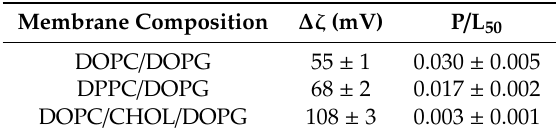
Table 1. Data from the z-potential measurements. Total change in the ζ value ( ∆ ζ ) and peptide to lipid ratio for half the total change in ζ (P / L 50